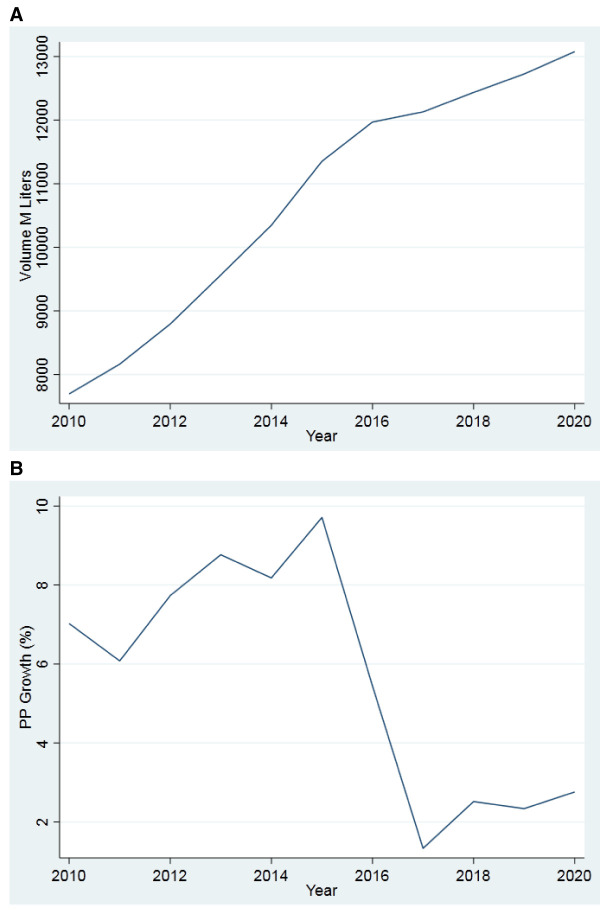
Sales volume of soft drinks in Saudi Arabi from 2010–2020.(
a) Sales volume in million liters; (
b) percentage growth from previous period (PP growth %).